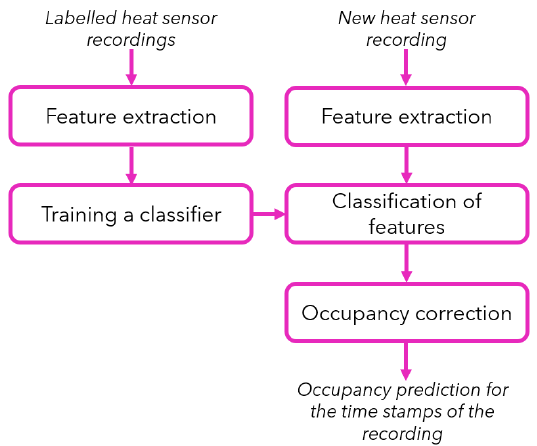
Figure 6. Workflow of the feature classification based occupancy prediction